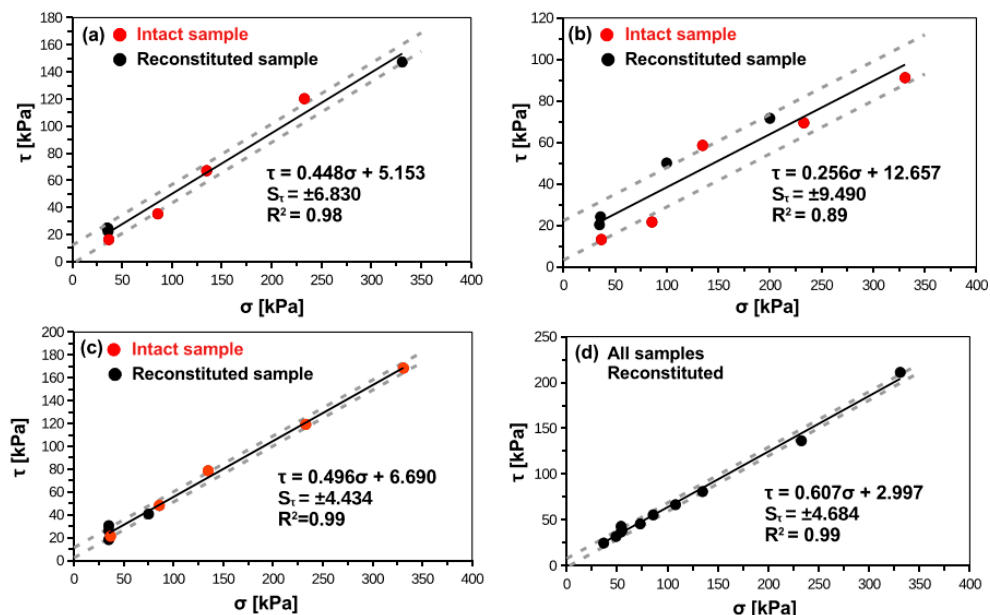
Figure 4. Mohr-Coulomb failure envelope of smooth concrete–soil interface for ( a ) silty loam, ( b ) organic clay, ( c ) peat, ( d ) organic silt.